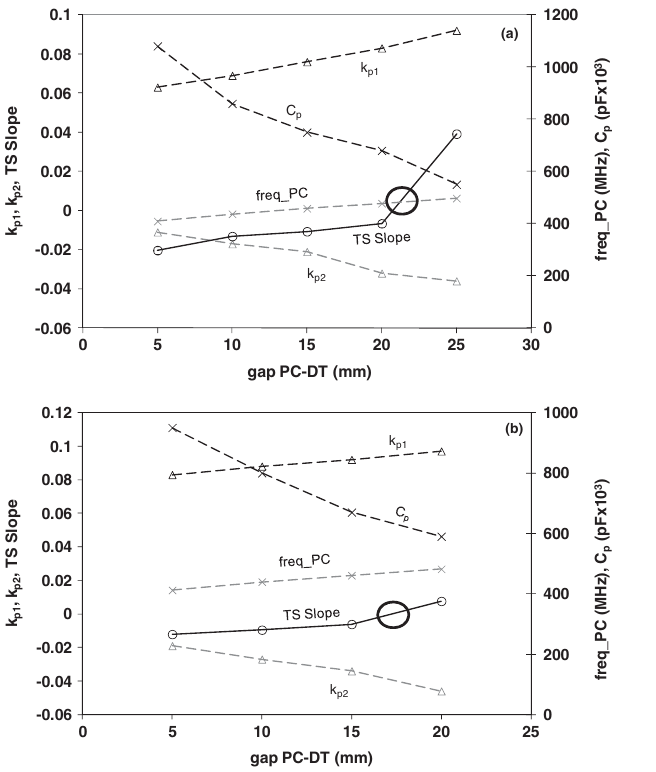
FIG. 25. Circuit parameters and tilt sensitivity slope as a function of the gap PC-DT for 5 PC (a) and 7 PC (b) configu- rations. The circles mark the value of gap PC-DT where the TS_Slope crosses the zero point. It should be the stabilizing gap PC-DT.